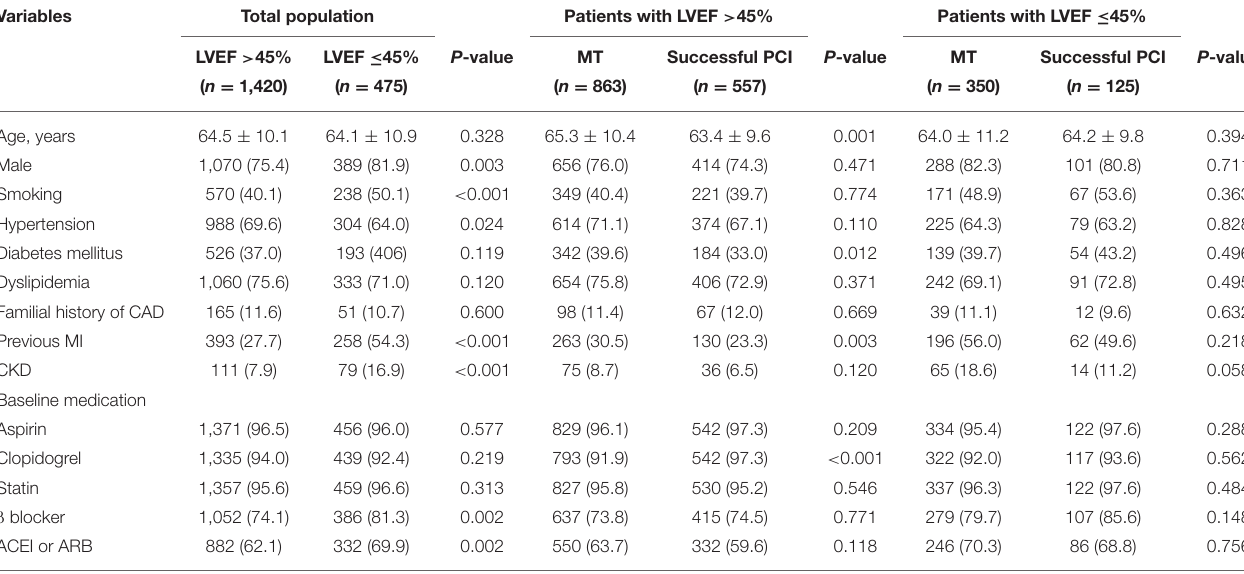
TABLE 1 | Baseline clinical characteristics of all patients with and without left ventricular systolic dysfunction, and of patients with and without left ventricular systolic dysfunction stratified according to management. Variables Total population Patients with LVEF > 45%